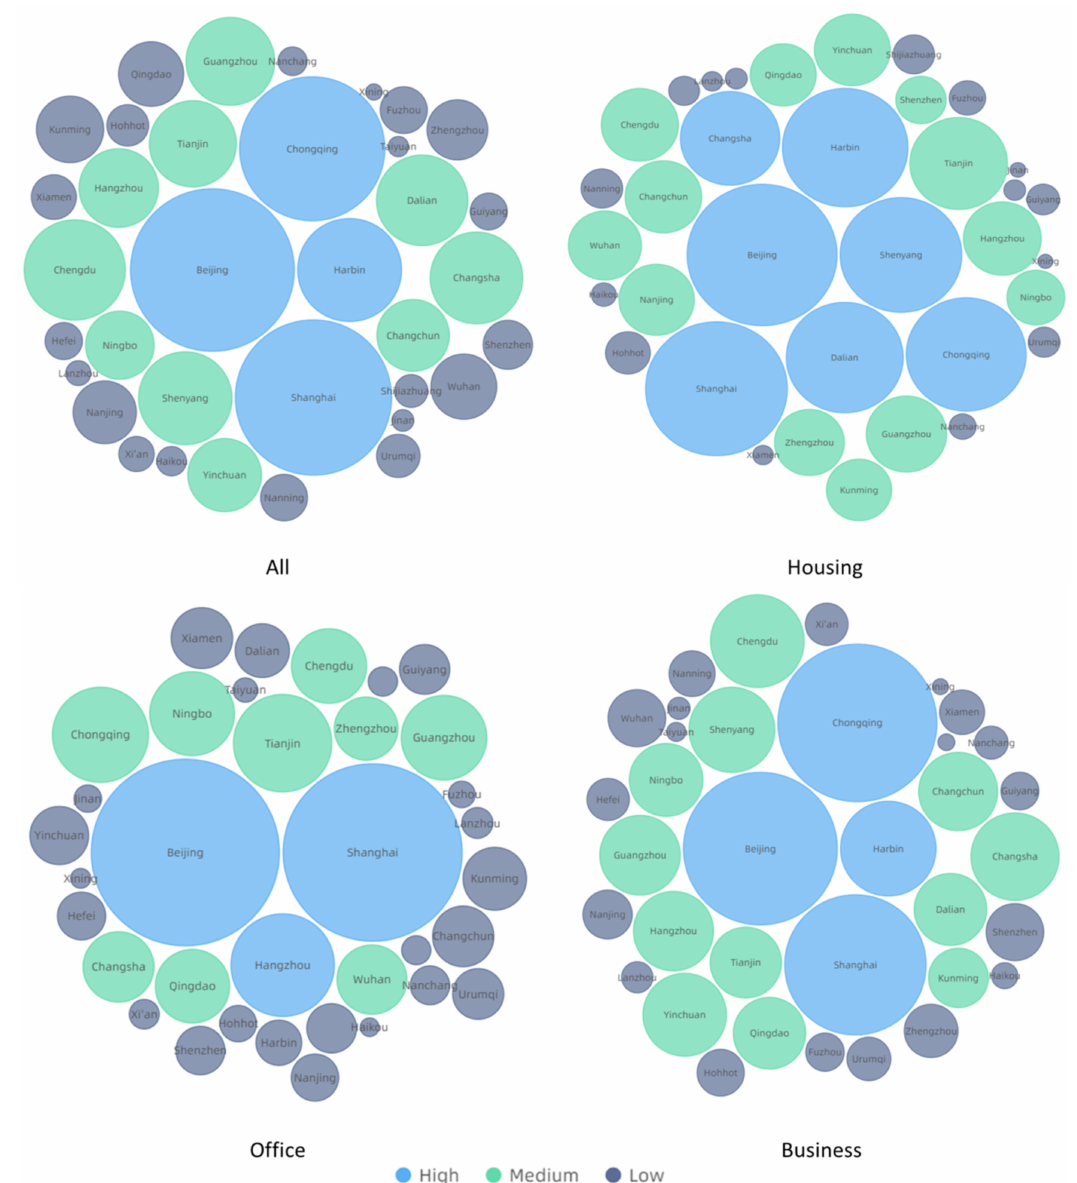
Figure 6. Real estate inventory classification based on 2010–2019